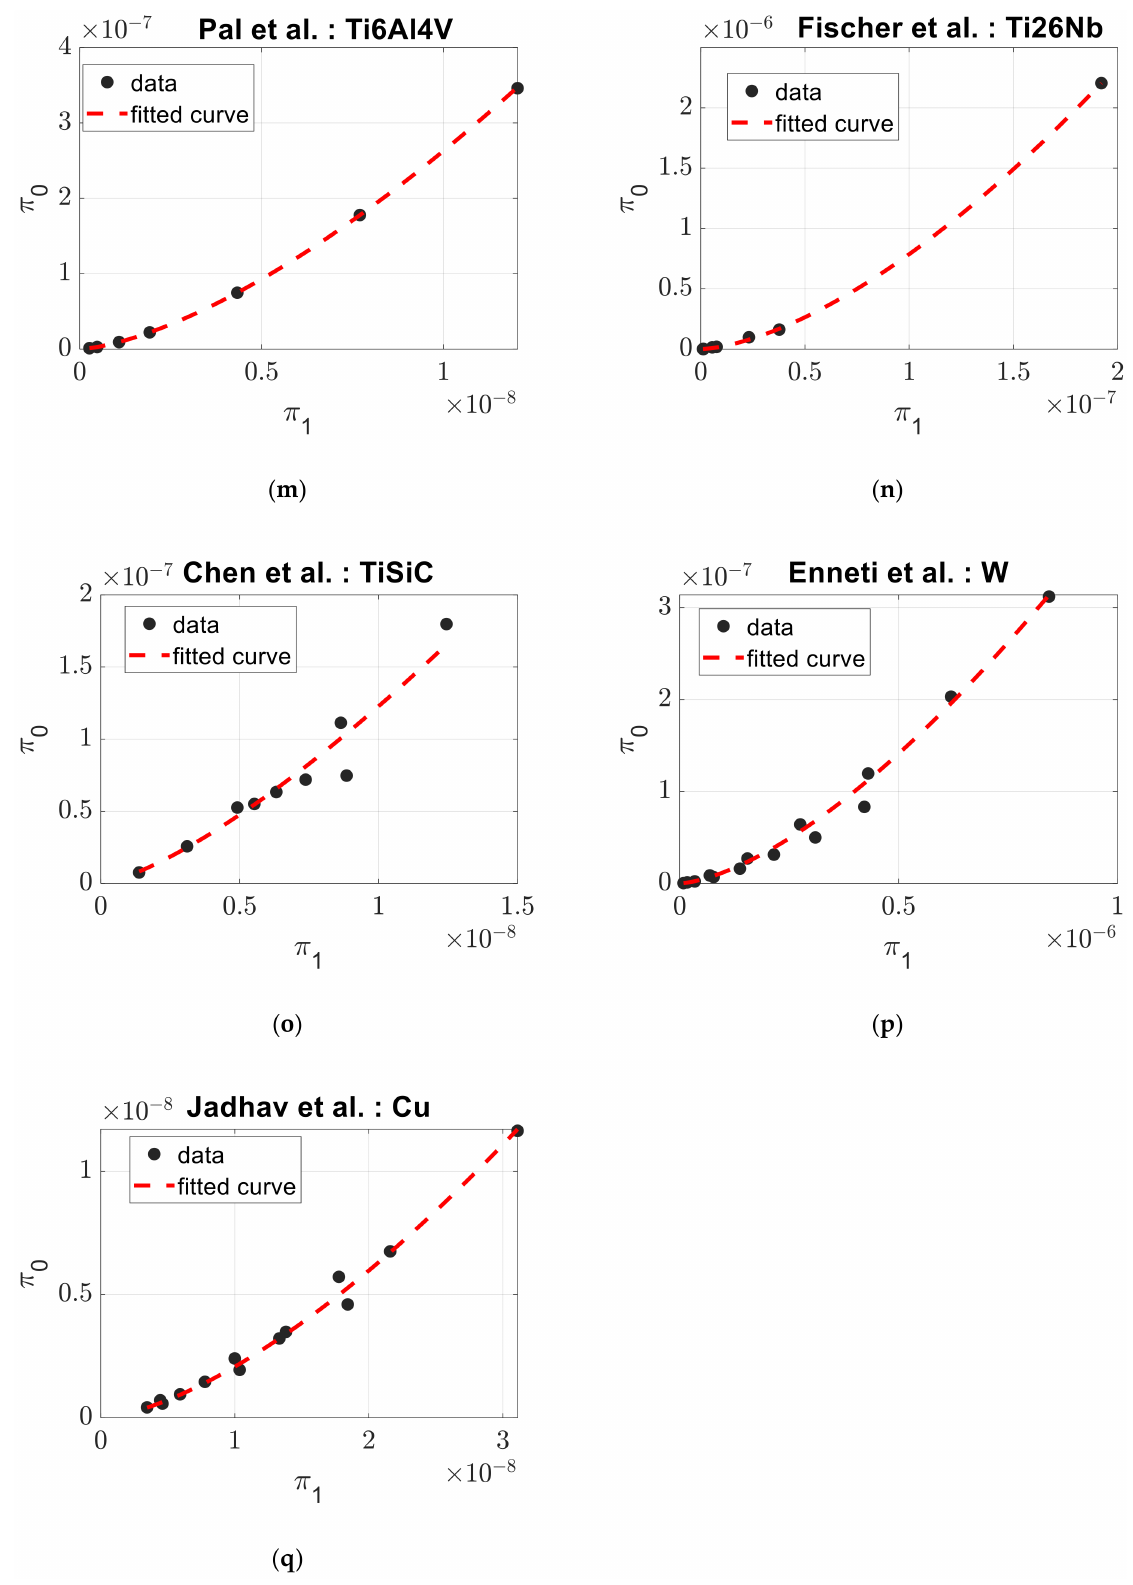
Figure 2. Computed curves of dependent ( π 0 ) versus independent ( π 1 ) dimensionless products fitted for different materials used to produce metallic components with the selective laser melting (SLM) process: ( a ) Estrada et al. [13] with In718, ( b ) Wang et al. [16] with In718, ( c ) Bai et al. [17] with AlSi10Mg, ( d ) Read et al. [18] with AlSi10Mg, ( e ) Kempen et al. [19]